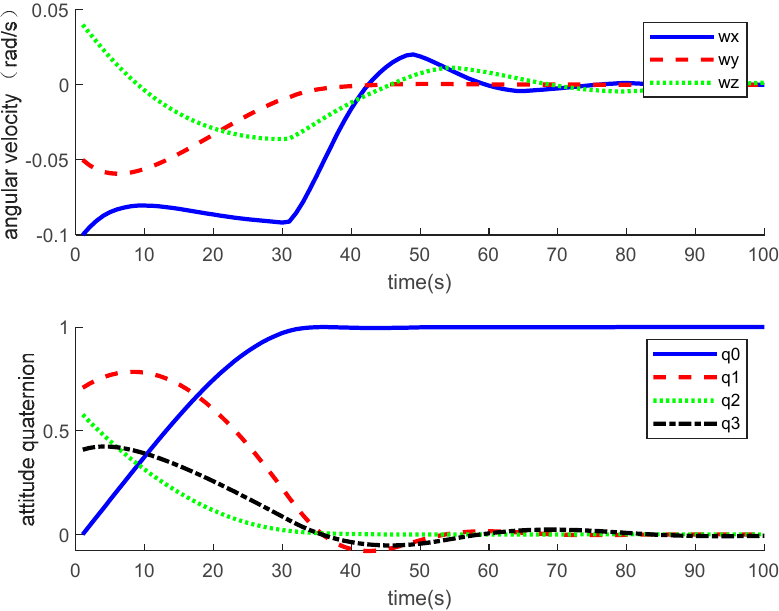
Figure 7. Curve of the system state under the standard PID controller with actuator failure.